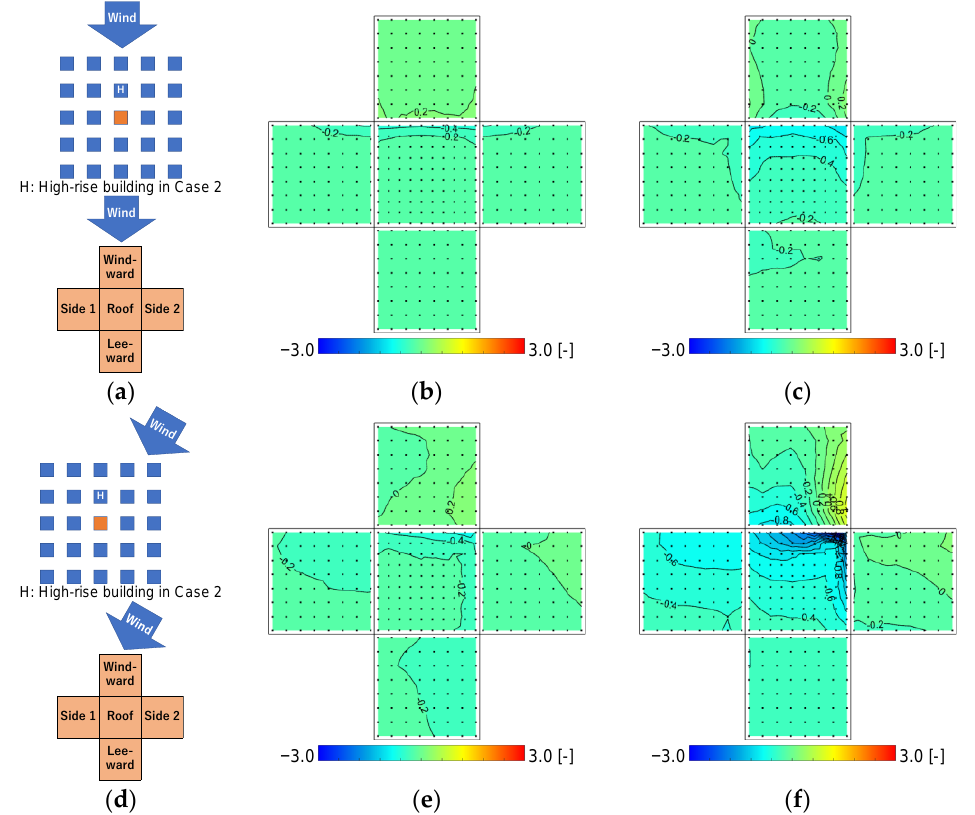
Figure 7. Mean wind pressure coefficient, C p ; ( a ) building model arrangement and prevailing wind direction for ( b , c ); ( b ) wind direction of 0 ◦ in Case 0 with no high-rise building; ( c ) wind direction of 0 ◦ in Case 2 with a high-rise building next to the pressure measurement model; ( d ) building model arrangement and prevailing wind direction for ( e , f ); ( e ) wind direction of 30 ◦ in Case 0; ( f ) wind direction of 30 ◦ in Case